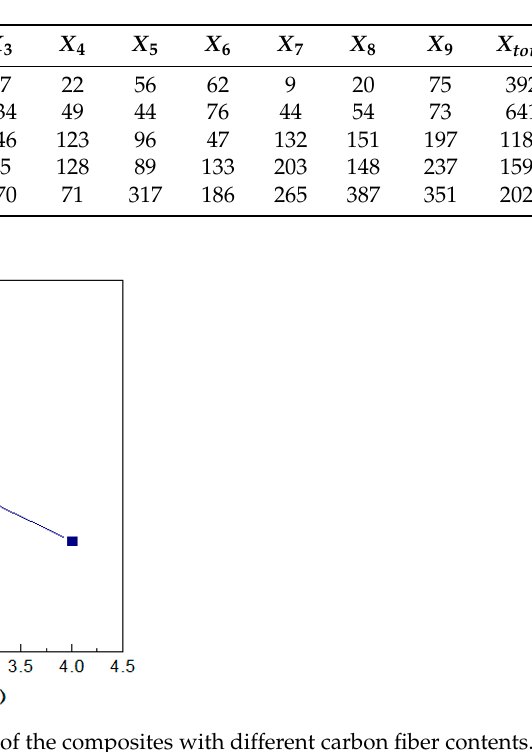
Table 2. Statistical number of carbon fibers in each subsection.